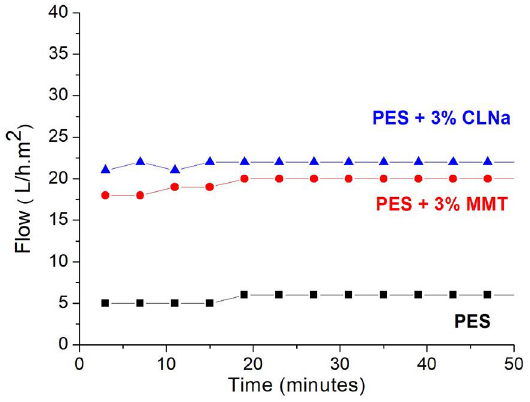
Figure 11 . Flow measures with water/oil emulsion for 1.0 bar